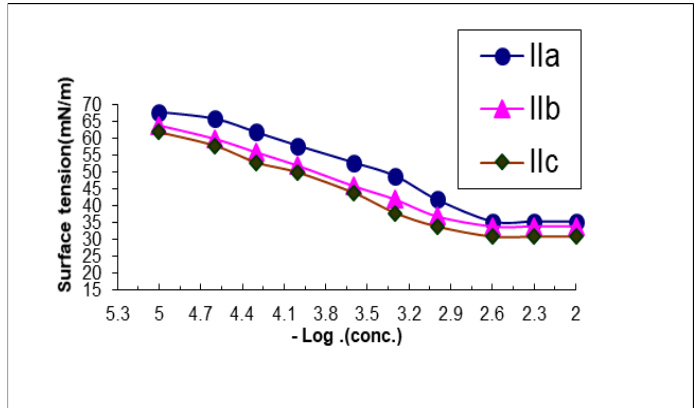
Figure 3. Variation in surface tension of surfactants IIa-c vs. concentration at 25 °C concentration expressed as mol/L.